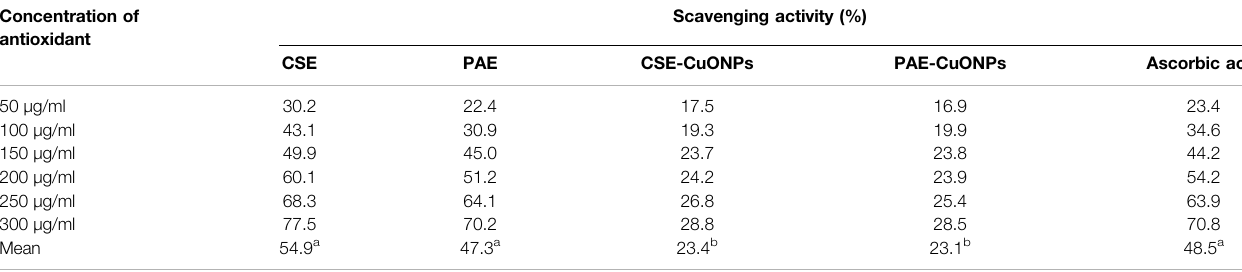
TABLE 6 | Antioxidant activity percentage of the plant extracts and green synthesized copper nanoparticles. Concentration of